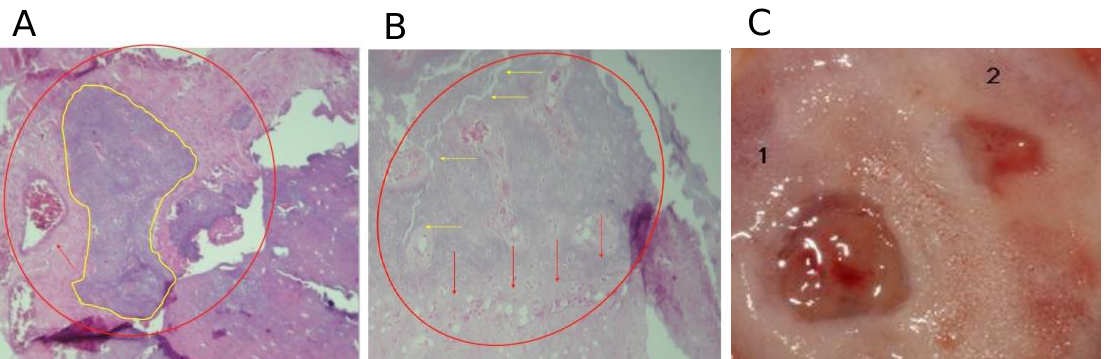
Figure 6. Histological analyses of the defect implanted in the animals. ( A ) The defect was implanted with colloidal NHAP-Q chitosan dispersion (protocol B, Group 1, 4 weeks). Mineralized tissue is shown in yellow, and the black arrow points to connective tissue. ( B ) The defect was implanted with colloidal NHAP-Q chitosan dispersion (protocol B, Group 1, 8 weeks). Black arrows point to the formation of laminar bone, and white arrows point to the bony bridge between the new and basal bone. ( C ) Clinical view at 8 weeks using (1) NHAP-Q and (2) colloidal AgNP-Q chitosan dispersion. Magnification, 10×. Hematoxylin and eosin.